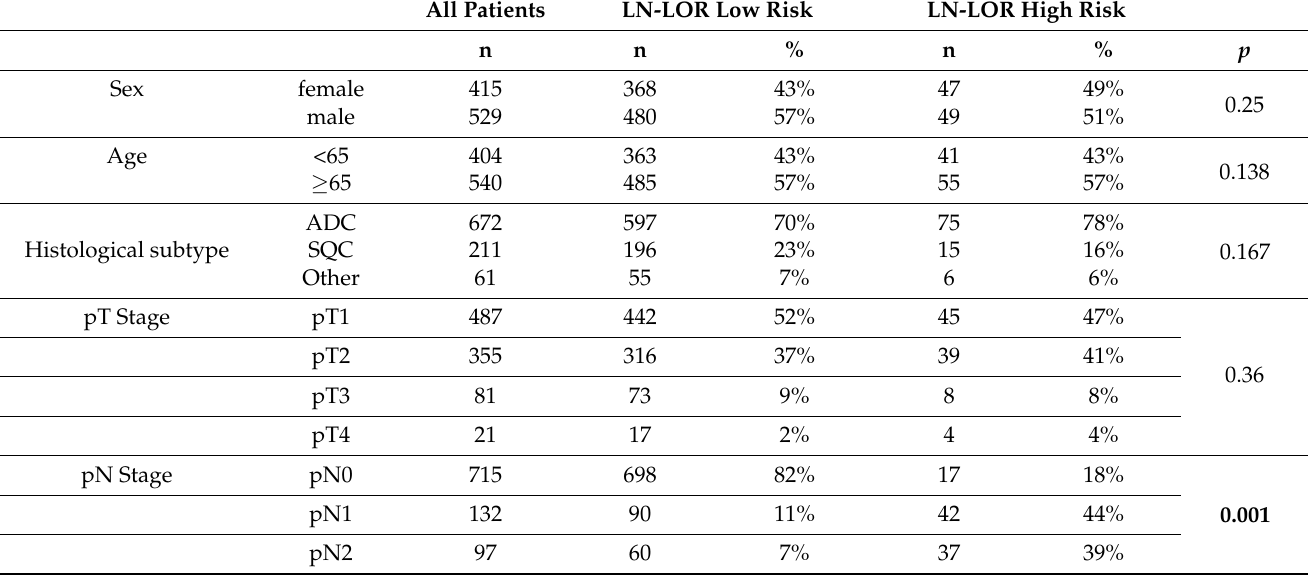
Table 2. Association of lymph node log-odds ratio (LN-LOR) risk groups with clinical and pathological parameters in a cohort of 944 patients undergoing lobectomy for stage I-III NSCLC. All Patients LN-LOR Low Risk LN-LOR High Risk All Patients n n % n %